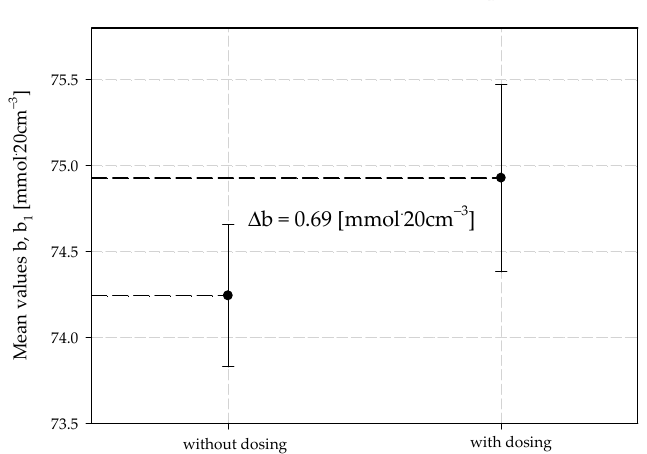
Figure 13. Ammonium chloride concentration values with and without dosing AAB to B10. Total ammonia conc. with and without dosing AAB to B10